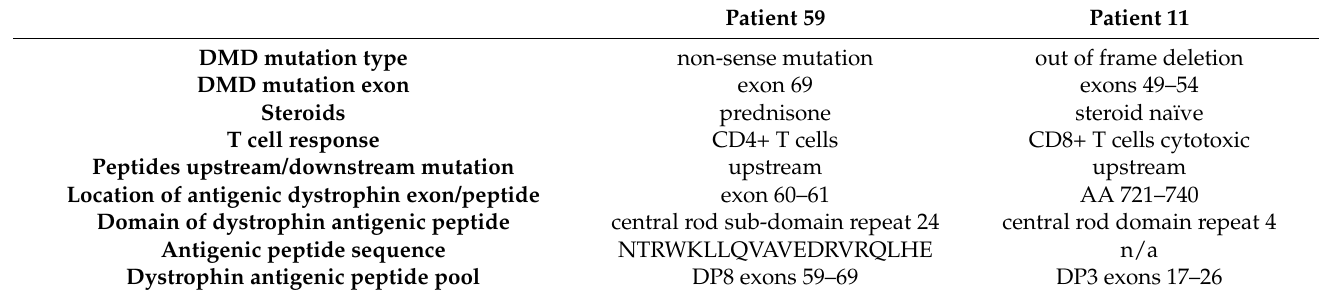
Table 1. T cells targeting dystrophin epitopes in two DMD patients with different dystrophin mutation [15]. Patient 59 Patient